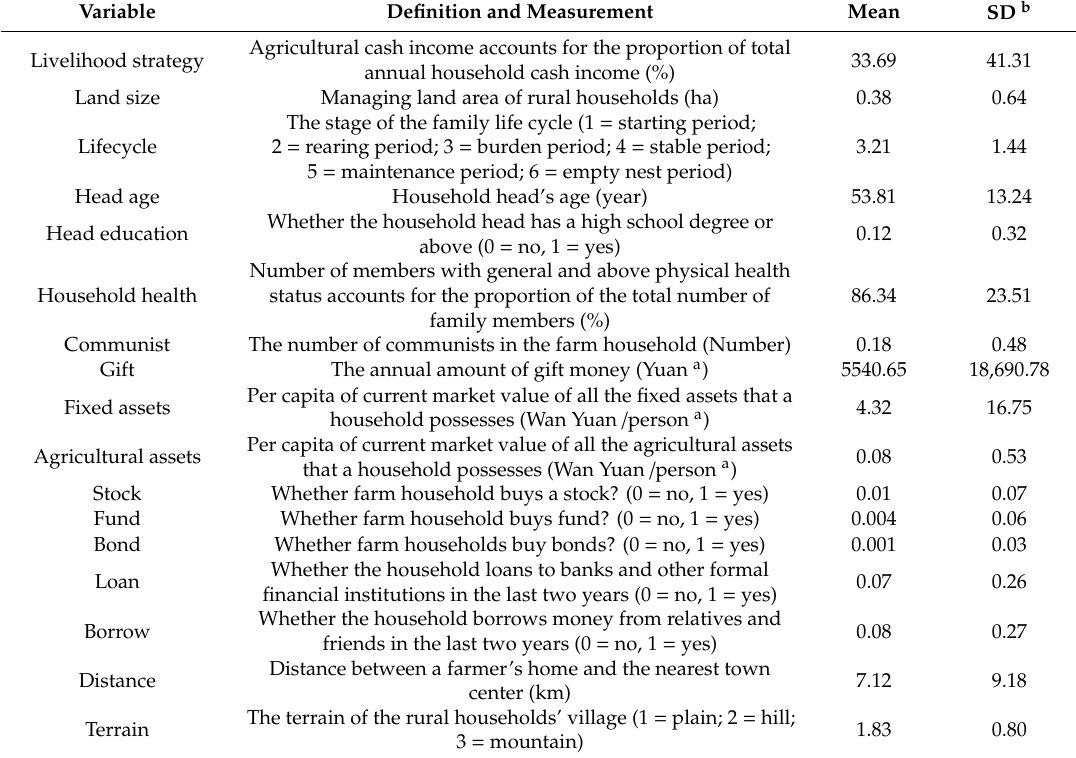
Table 2. Definition of model variables and descriptive statistical analysis.